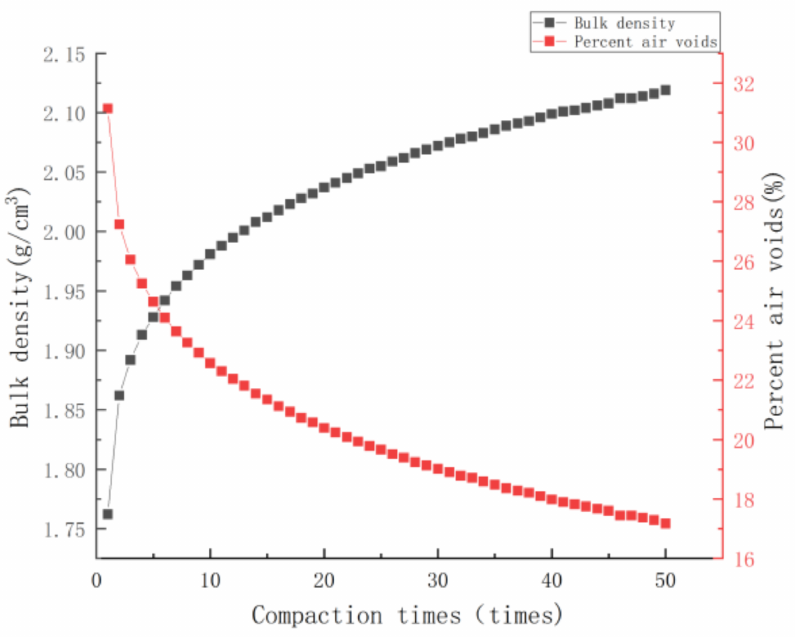
Figure 6. Variation of volume parameters of OLSPM-25 with compaction times at 50 compaction